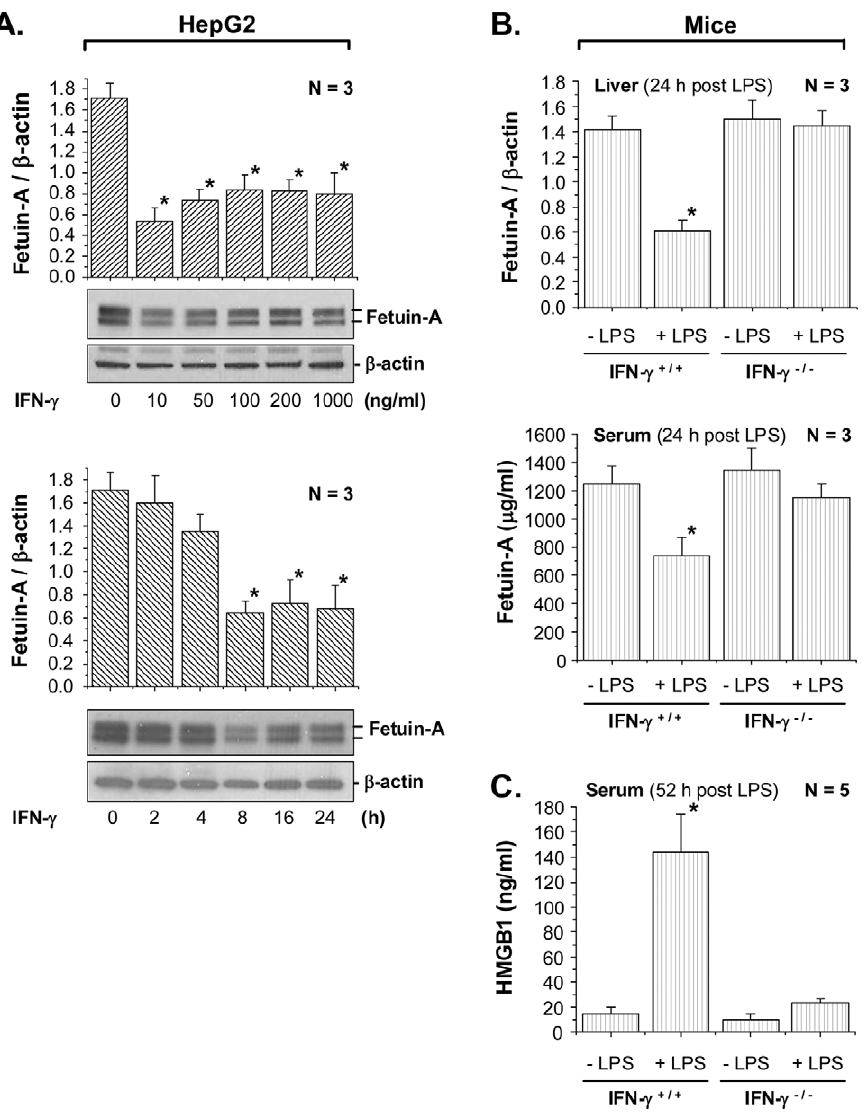
Figure 2. IFN- c counter-regulates hepatic fetuin-A expression. A ). IFN- c decreased fetuin-A expression levels in hepatocytes . HepG2 cells were stimulated with IFN- c for 16 h at different doses ( Top Panel ), or at 50 ng/ml for different time periods ( Bottom Panel ), and cellular fetuin-A/ b -actin ratio was assessed by Western blotting analysis. B, C ). Disruption of IFN- c expression rendered mice resistant to LPS-induced down-regulation of hepatic fetuin-A expression . LPS (10 mg/kg) was administered into wild-type or IFN- c -knockout Balb/C mice, liver and blood was harvested at 24 h ( Panel B ) or 52 h ( Panel C ) post endotoxemia to assess fetuin-A ( Panel B ) or HMGB1 ( Panel C ) levels by Western blotting analysis. Hepatic fetuin-A levels, as a ratio to b -actin, were expressed as mean 6 SD of multiple independent experiments (N=3–5). *, P , 0.05 versus control (‘‘-LPS’’). rates were monitored. In an animal model of cerebral ischemia (local inflammation), there was no difference in susceptibility between sex- and body weight-matched (male, 27–30 g) wild- type and fetuin-A KO mice [43]. However, the animal survival rates were significantly lower in the fetuin-A KO mice as compared with wild-type C57BL/6J mice following endotox- emia ( Fig. 3A, top panel ) or sepsis ( Fig. 3A, bottom panel ). Consistently, disruption of fetuin-A expression led to significant elevation of serum HMGB1 levels at 48 h post endotoxemia (8226 ng/ml for Fet + / + mice, versus 181 6 45 ng/ml for Fet 2 / 2 mice; N=10, P , 0.05) or sepsis (125 6 46 ng/ml for Fet + / + mice, versus 271 6 34 ng/ml for Fet 2 / 2 mice; N=12, P , 0.05). These experimental data suggest a protective role for a liver-derived negative APP, fetuin-A, in systemic inflammatory diseases.